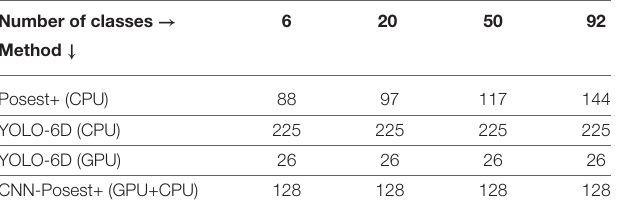
TABLE 3 | Inference times (in ms) for various numbers of classes (sub-datasets of the YCB92). Number of classes → 6 20